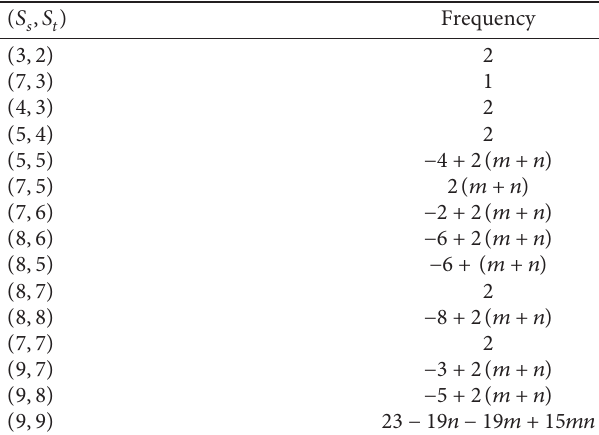
Table 6: Edge partition of Si